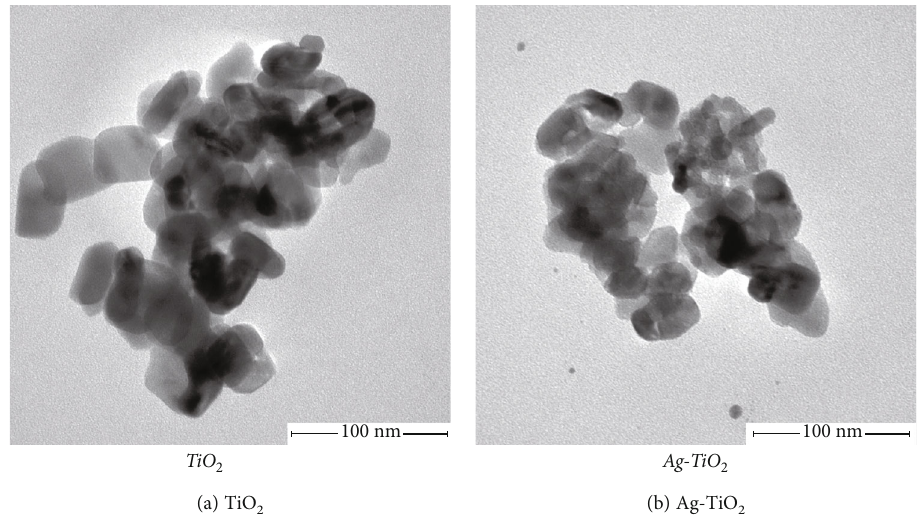
Figure 2: TEM image of (a) TiO